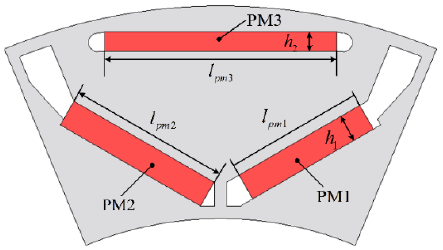
Figure 3. Design variables of the proposed machine. Table 2. Definitions and variation range of the design parameters of proposed MAS-IPM machine.